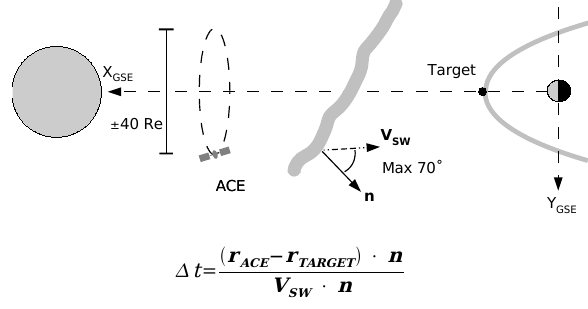
Fig. 2. Determination of solar wind propagation delay. The real position of the solar wind monitor, r ACE , as well as the orientation of the phase front, n , are taken into